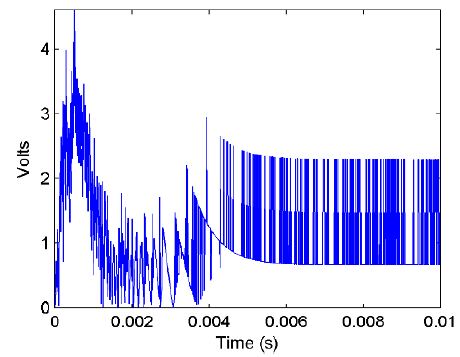
Figure 23. PVSE output absolute error.